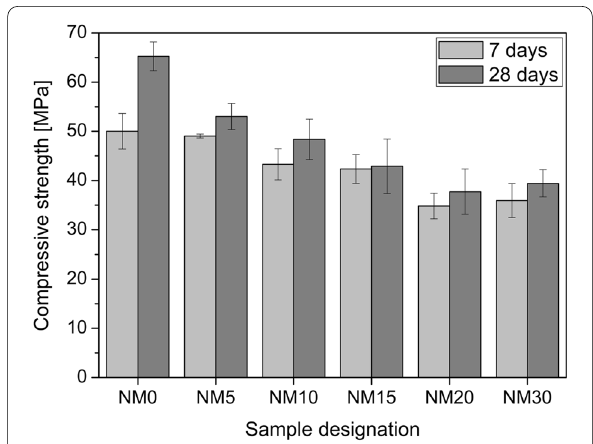
Fig. 6 Compressive strength of cement pastes after 7 and 28 days of curing